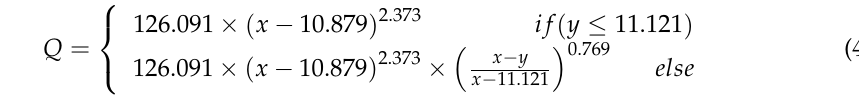
Figure 5. Rating curve considering the backwater effect based on ADVM data 𝑄 = (cid:4688)64.522 (cid:3400) (𝑥 − 10.057) (cid:2870).(cid:2872)(cid:2869)(cid:2873)